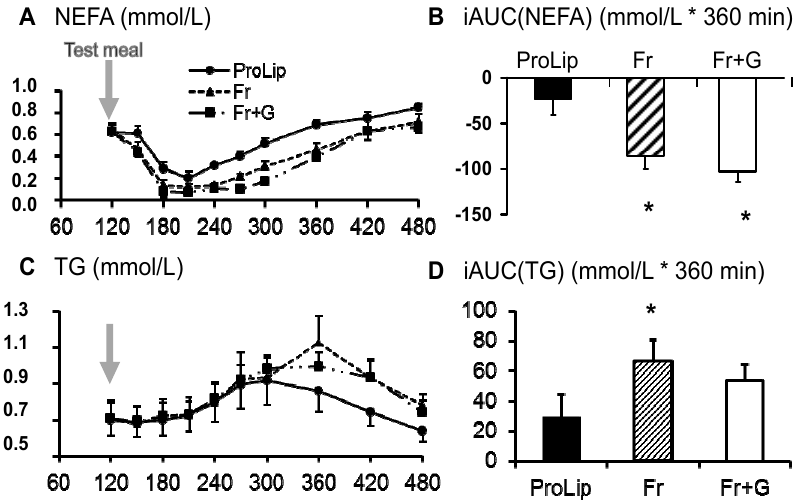
* p < 0.05 vs . ProLip, $ p < 0.05 vs .